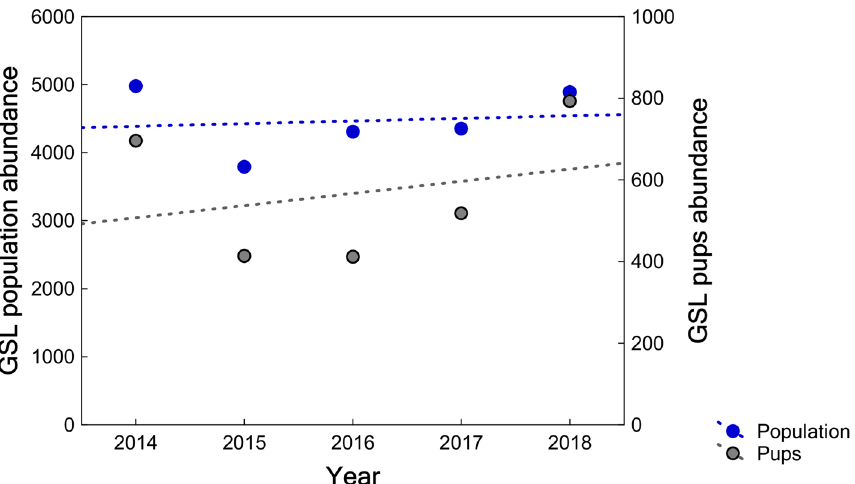
Figure 2. Galapagos sea lions’ population and pup abundance trend in the Galapagos Archipelago from 2014 to 2018. It includes the annual counts at 32 breeding rookeries on 13 islands distributed throughout the archipelago. Blue and gray circles show the total population and pup population, respectively. Blue and gray dashed lines show the population trend and the pup trend, respectively.